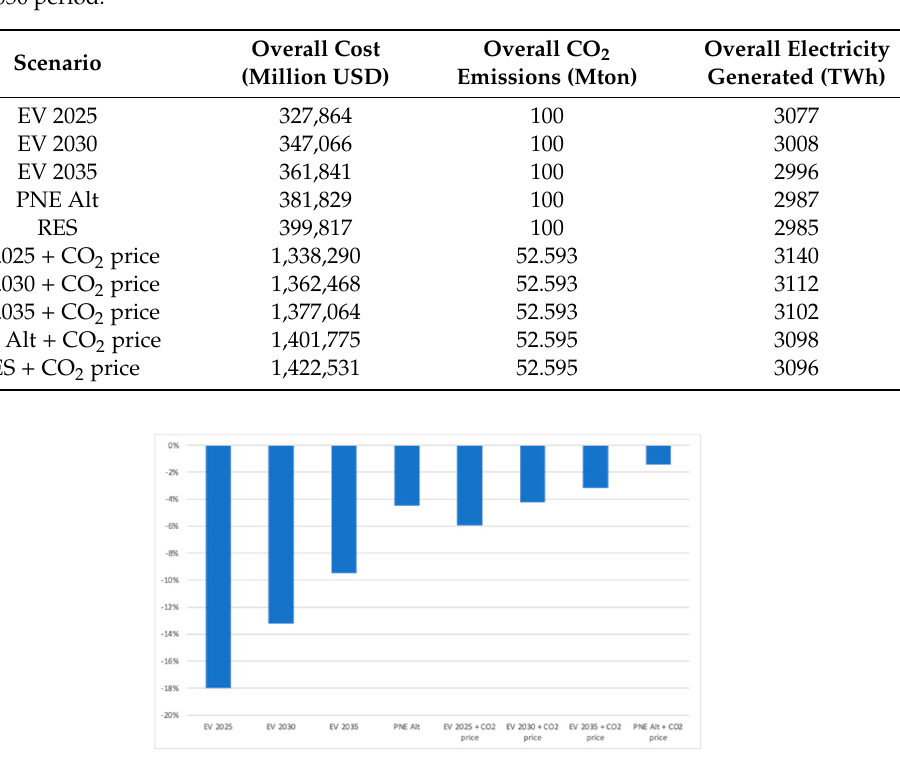
Figure 4. Percentage variation in overall energy system costs for different time frames of EV adoption—comparison with reference scenarios (with and without a CO 2 price).